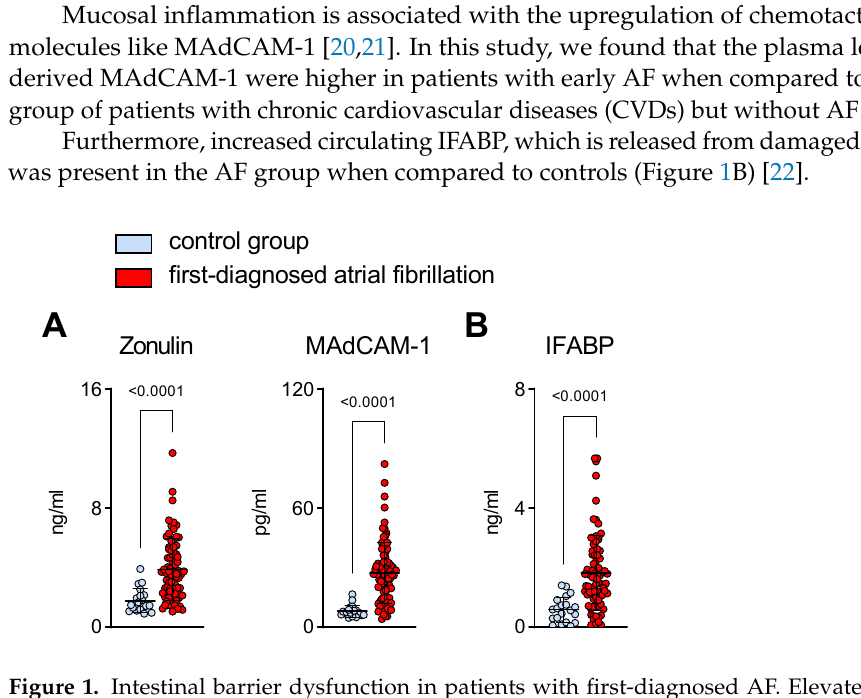
Figure 1. Intestinal barrier dysfunction in patients with first-diagnosed AF. Elevated circulating biomarkers suggestive of intestinal inflammation ( A ) (zonulin and mucosal endothelial cell adhesion molecule, MAdCAM-1) and enterocyte damage ( B ) (intestinal fatty acid binding protein, IFABP) that are associated with abnormal intestinal permeability. Patients with first-diagnosed AF ( n = 80) were compared to controls (patients with chronic cardiovascular diseases but without AF) ( n = 20). Results are expressed as single values, mean ± SD, and p